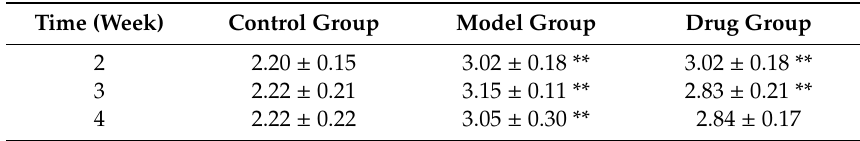
Table 3. The change of liver index (%) in